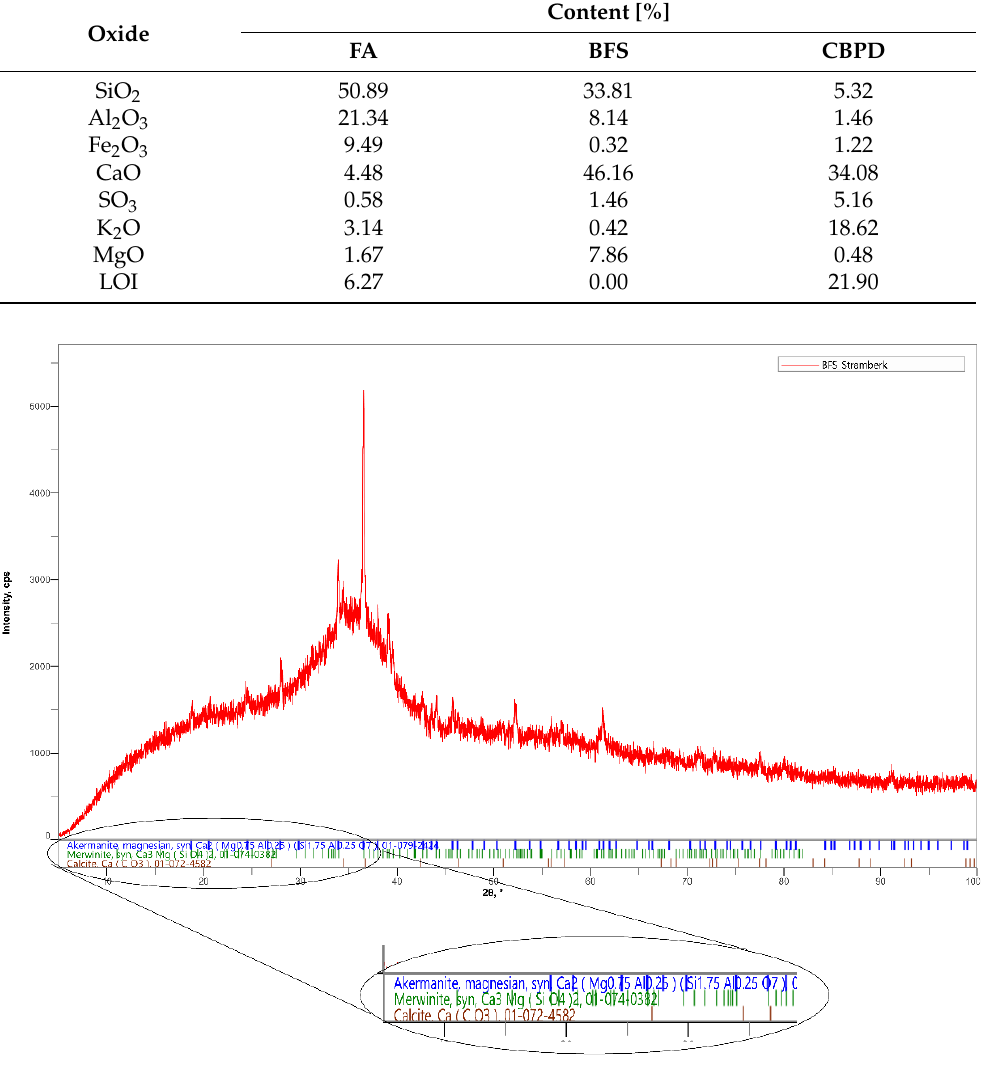
Table 1. Content of selected oxides in input raw materials. (FA—fly ashes, LOI—Loss on Ignition). Oxide